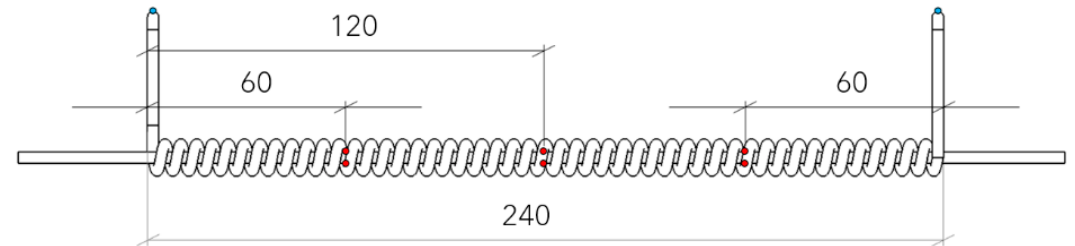
Figure 2. Schematic of the test section for the 2.5 mm ID smooth tube.